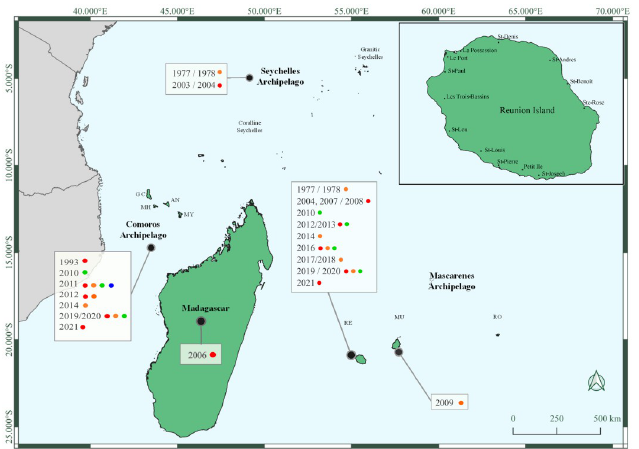
Fig 1. Islands of the southwestern Indian Ocean. The enlargement on the top right details the map of Reunion Island with the locations of the main cities. The rectangles show the dengue history in the region. The different dates correspond to the DENV outbreaks, and the colored circles represent the serotypes responsible for these outbreaks, red for DENV-1, orange for DENV-2, green for DENV-3, and purple for DENV-4. Cartographic data: administrative boundaries for Mayotte and Reunion Island come from OpenStreetMap; administrative boundaries for other countries come from ICPAC Geoportal. Software: QGIS3.10. Map was created using QGIS. Basemap: GADM data (https://www. gadm.org/data.html). AN, Anjouan; CS, Coralline Seychelles; DENV, dengue virus; GADM, Global Administrative Areas; GC, Grande Comore; GS, Granitic Seychelles; MH, Mohe´li; MU, Mauritius; MY, Mayotte; RE, Reunion Island; RO,